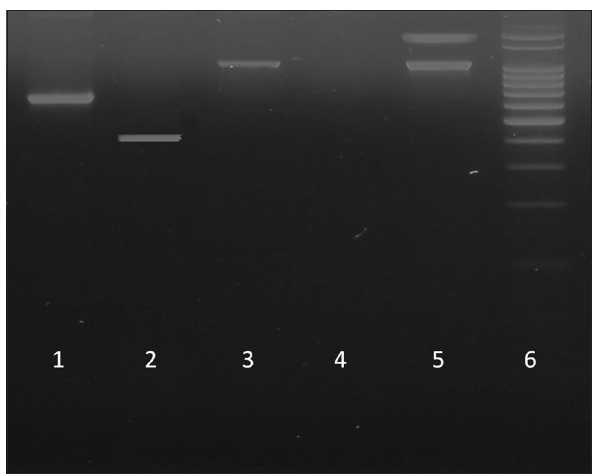
Figure-1: Electrophoresis gel of polymerase chain reaction products. Lane 1: CapD ; Lane 2: KMT1 ; Lane 3: CapA ; Lane 4: Negative control ; Lane 5: CapD ; Lane 6: Ladder ( 100bp ) .